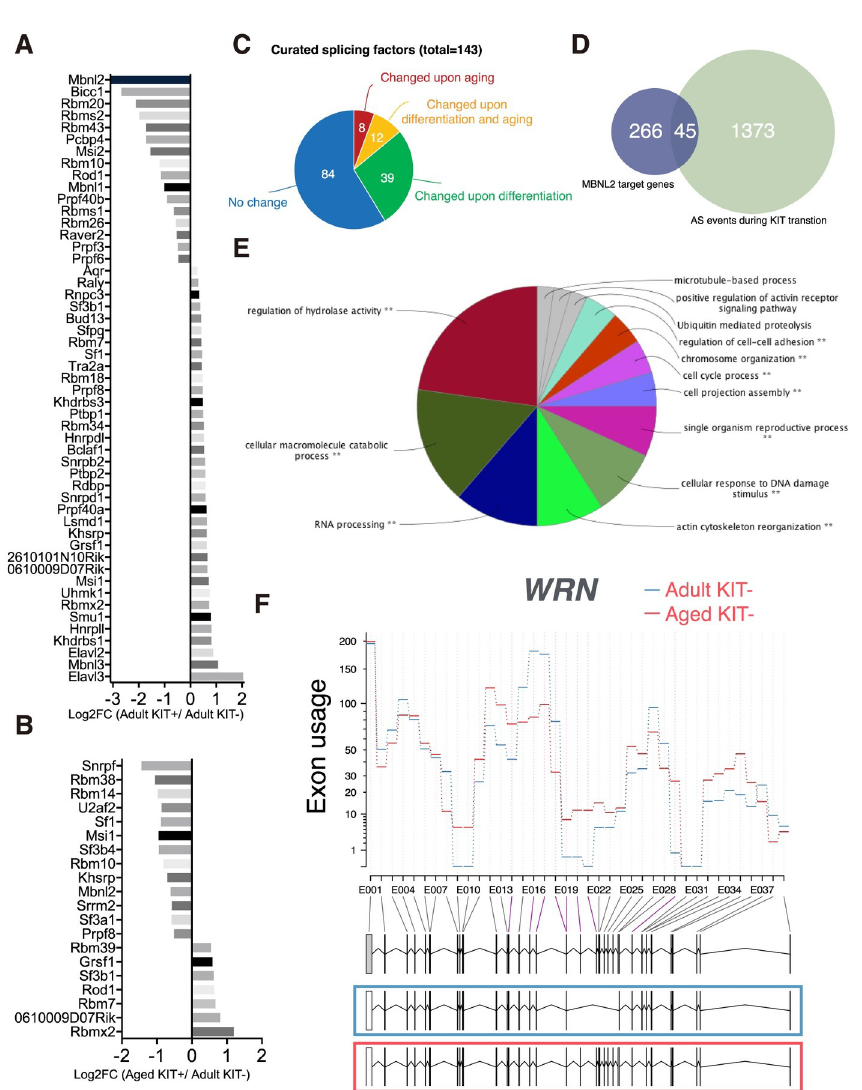
Fig 3. Post-transcriptional regulation during SSC differentiation and aging. (A-B) Column bar chart shows the fold change of splicing factors identified as differentially expressed during differentiation (A) and aging (B). (C) Pie chart showing the proportion of splicing factors whose expression levels were altered during SSC differentiation and aging. (D) Venn diagram of the overlap between MBNL2 target genes and differential alternative splicing events detected during differentiation. (E) GO enrichment analysis of the altered genes by comparing adult and aged undifferentiated SSCs. (F) The example of WRN showed differential exon usage upon aging, indicating regulated isoform expression level at different